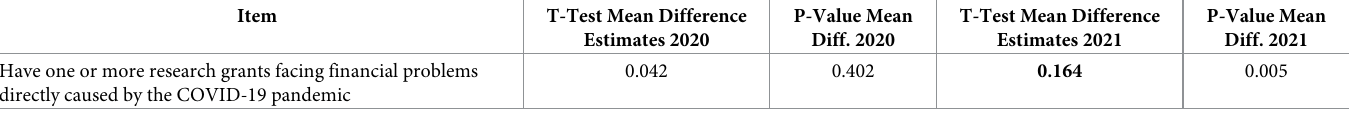
tested for COVID-19. Findings, regarding the 2020 survey are reported in Table 4. Even after controlling for individual and organizational covariates, women are more likely to indicate that COVID-19 related policies have caused publishing disruptions (p < 0.01) and inability to concentrate (p < 0.01). Estimates for the unanticipated childcare responsibility, however, were not significant anymore at the 0.01 level. Table 3. Gender differences in 2020 and 2021 regarding the question: Do you currently have one or more research grants that are facing financial problems that are directly caused by the COVID-19 pandemic?. Item